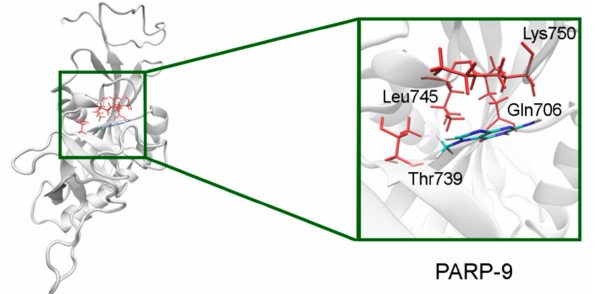
Figure 13. 7-MG position in the NA binding site of PARP-9 obtained using homology modeling. The Gln706 main chain forms hydrogen bonds with the lactam group. The C γ atom of Thr739 forms a hydrophobic contact with the 7-MG methyl